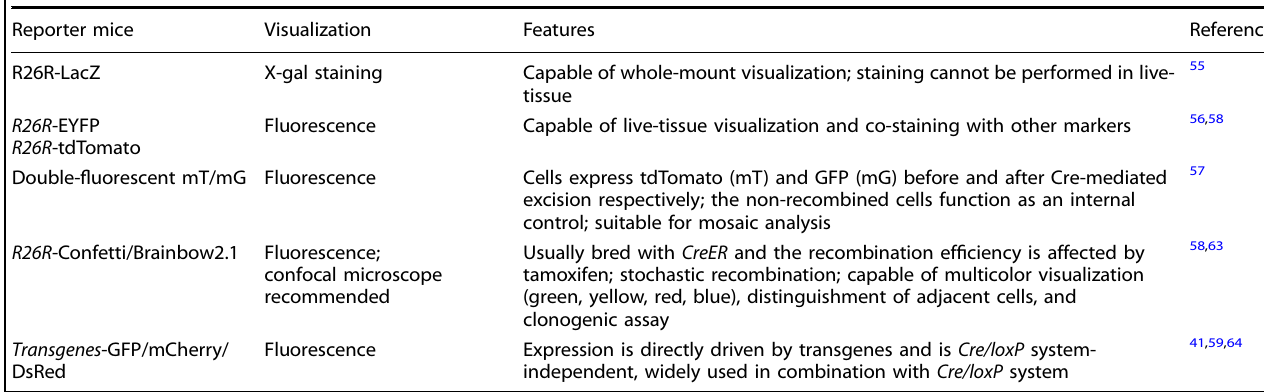
Table 1. Comparison of different reporter mice based on Cre/loxP system Reporter